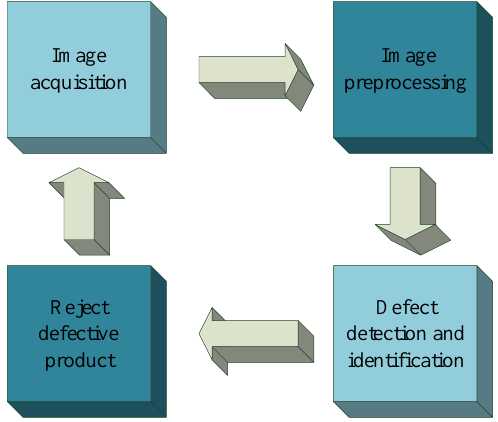
Figure 3 The process of the defect detection Figure 3. The process of the defect detection.